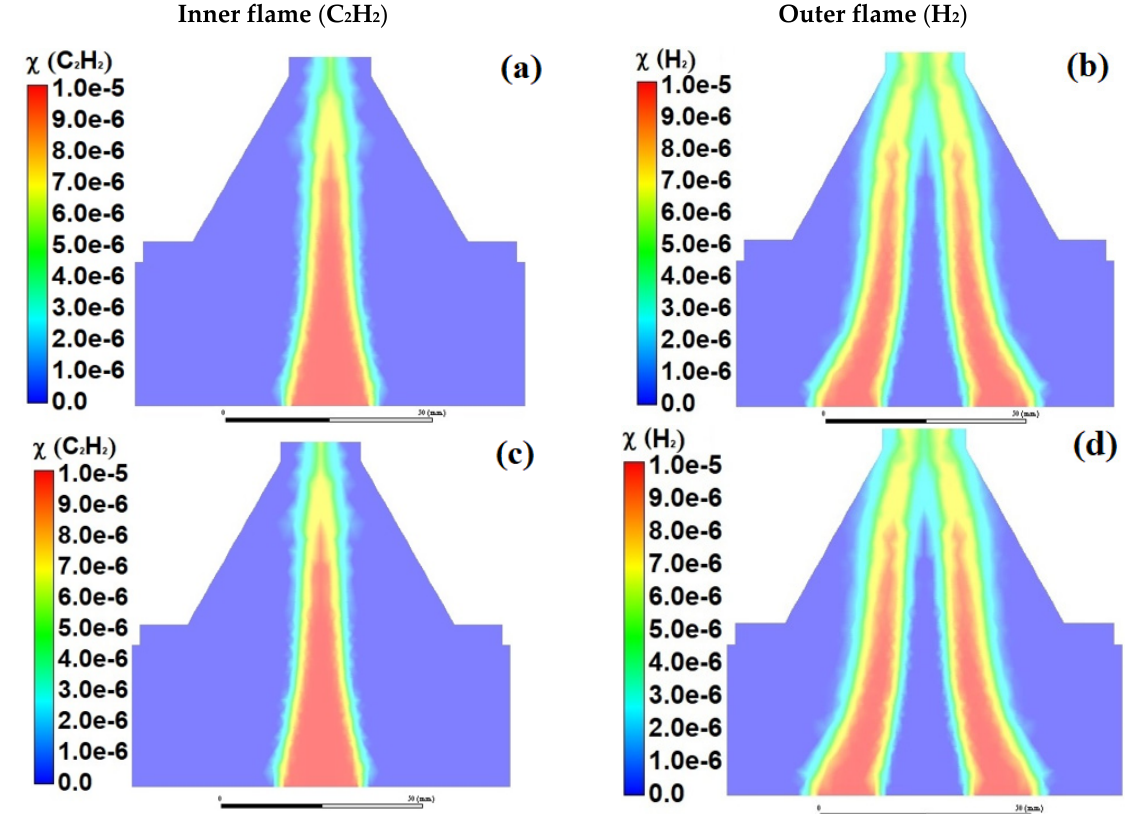
Figure 7. Cross-sectional distribution of H 2 and C 2 H 2 tracer gases (mole fraction) in inner and outer premixed flames of C 2 H 4 /air ϕ = 1.77 and CH 4 /air ϕ = 1.2, respectively, at atmospheric pressure ( a , b ) and 10 bar ( c , d ).